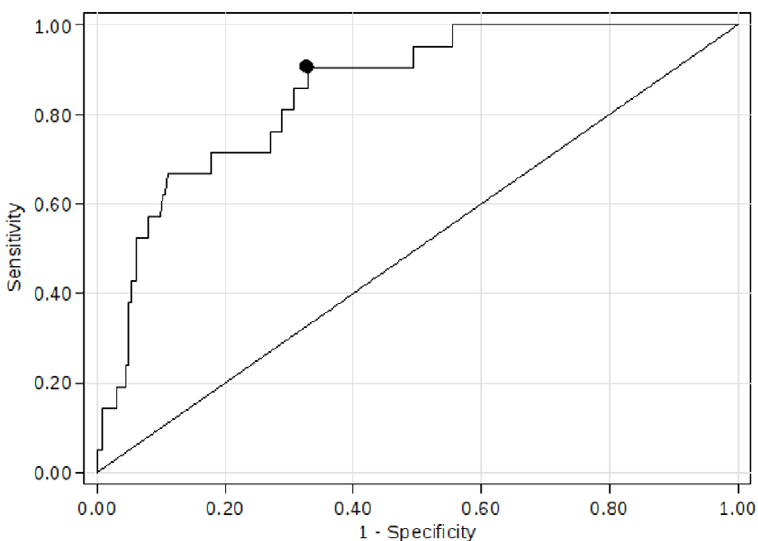
Figure 2. Receiver-operating characteristic curve for the concentration of soluble TRAIL in relation to the primary end-point (death and heart failure). The closed black dot on the curve shows the concentration of TRAIL (44.6 ng/mL) with the optimal combination of sensitivity and specificity.